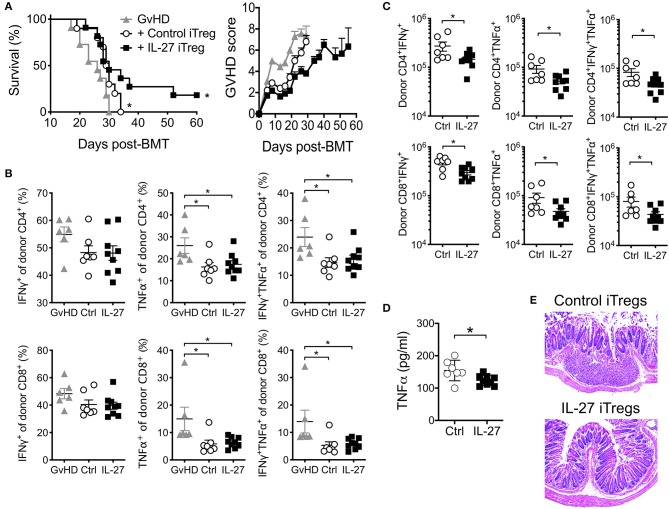
Adoptive transfer of polyclonal iTregs diminished aGVHD disease. Mice were induced aGvHD as in Figure 1. Polyclonal iTregs were generated and restimulated as in Figure 2 with immobilized anti-CD3 (2 μg/ml), anti-CD28 (2 μg/ml), IL-2 (100 U/ml) in the presence or absence of rIL-27 (10 ng/ml) for 24 h before 2.5 × 106 sorted Foxp3+cells were transferred into GvHD mice on the same day of disease induction. (A) Survival and GvHD score were examined. Data shown are from three independent experiments (10–11 mice per group). (B–D) Mice were sacrificed at day 14 post-GvHD induction. Proportion (B) and number (C) of donor T cells producing cytokines in spleen, and serum cytokine (D) were measured. Data are mean ± SEM. *p ≤ 0.05. (E) Representative colon histopathology images at 4 weeks after GvHD induction, 6 mice per group.